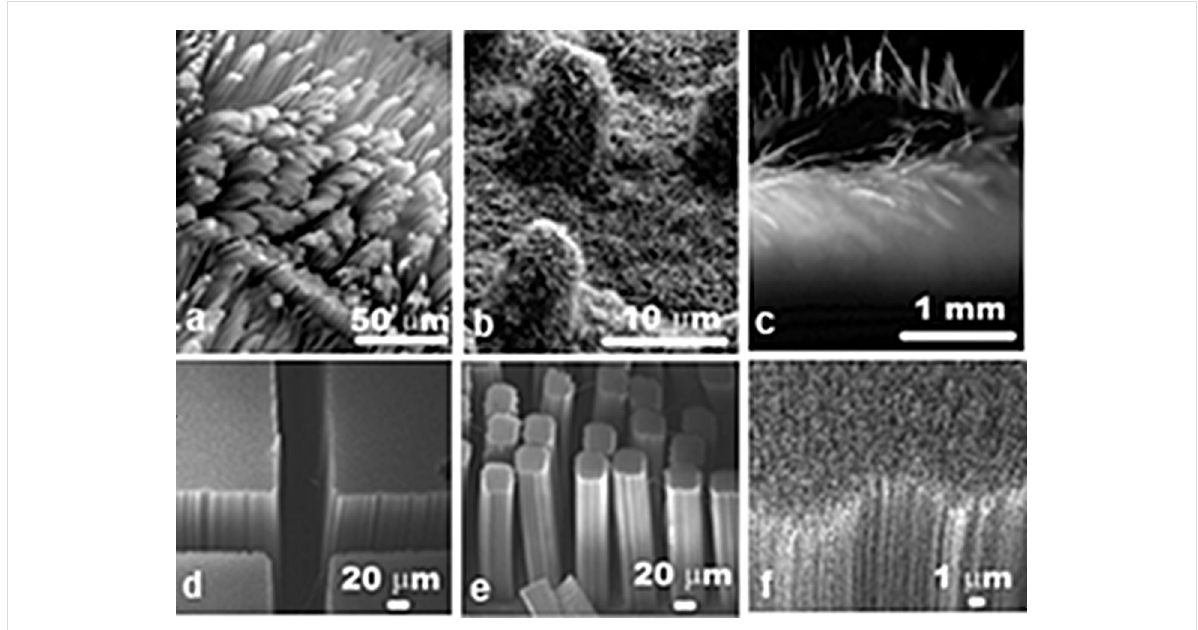
Figure 5: SEM images of natural (a) gecko setae, (b) a lotus leaf with hierarchical roughness, and (c) the hairy structure of lady’s mantle leaf. SEM images of synthetic setae made of micropatterned aligned carbon nanotubes where they act as spatulas (d-f). Adapted with permission from [66]. Copyright 2008 American Chemical Society.